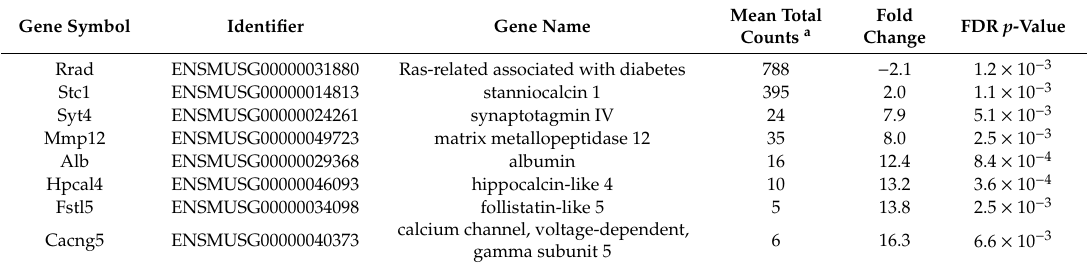
Table 4. Di ff erentially expressed genes involved in the regulation of calcium binding and